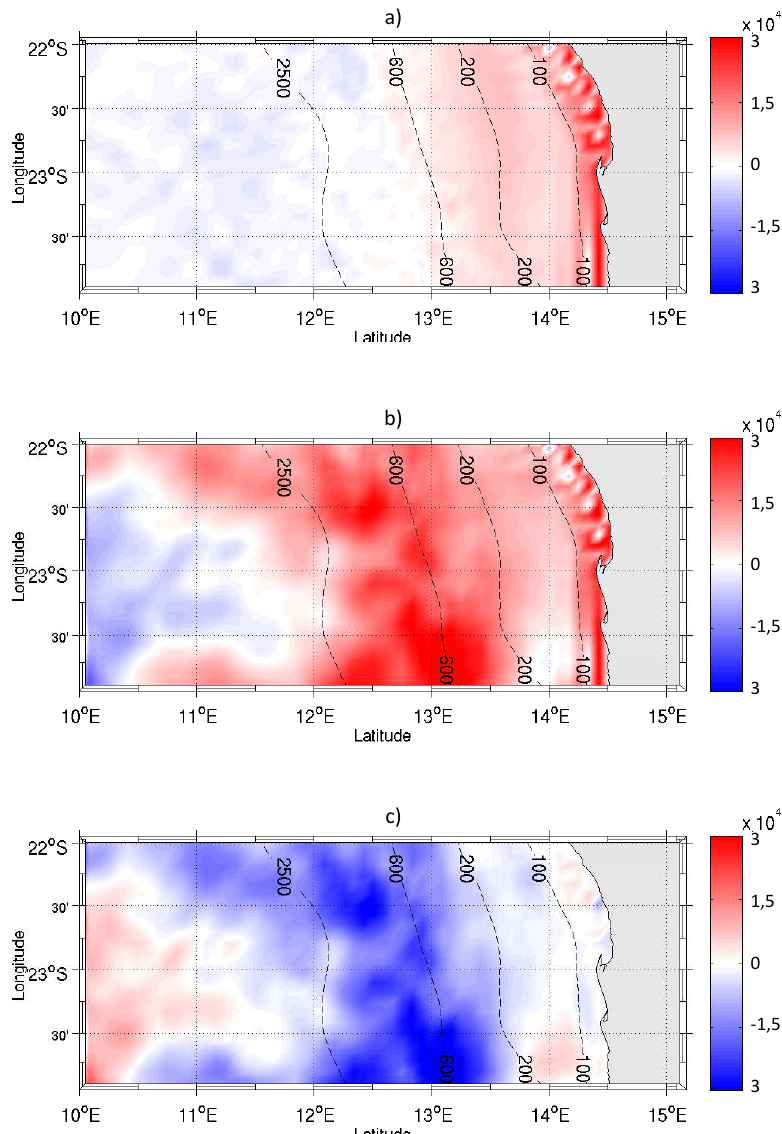
Fig. 5. Sum of zonal, meridional and vertical components of nitrate advection terms (mmol N m − 2 s − 1 ): total (a) , mean (b) , and eddy (c) contributions. Advections terms are 8yr averages, integrated over the whole water column. Positive sign represents a nitrate source and, negative sign, a